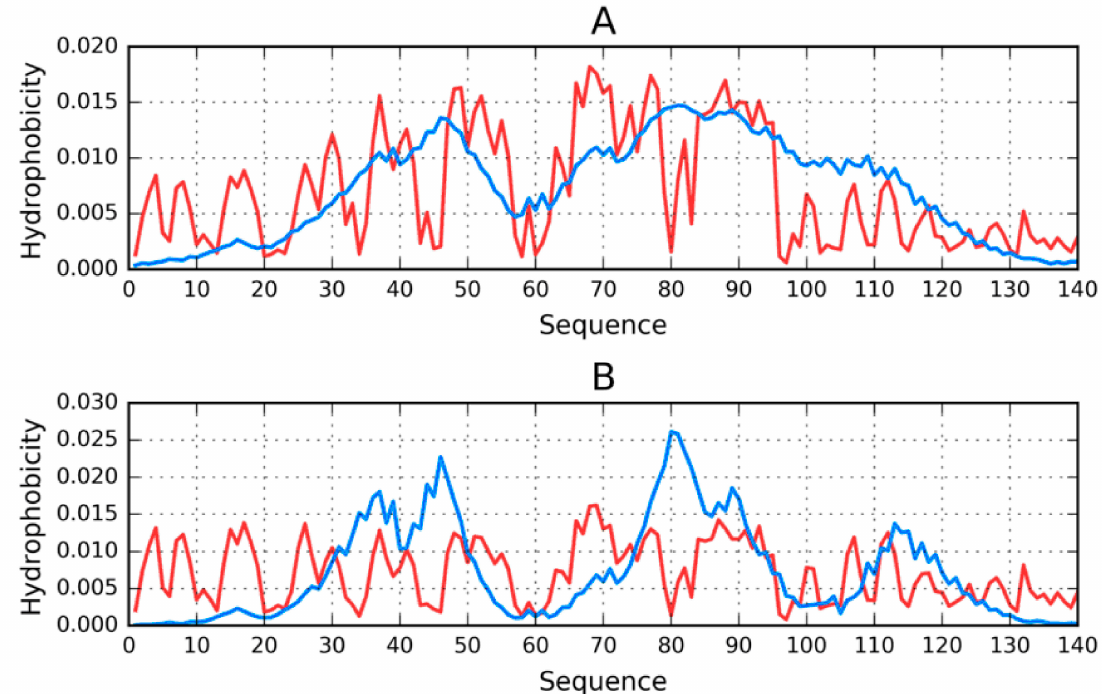
Figure 4. Theoretical (T, blue) and observed (O, red) hydrophobicity density distribution profiles for chain E (central) from the ASyn amyloid (2N0A); ( A )—Treated as part of the complex; ( B )—Treated as a standalone